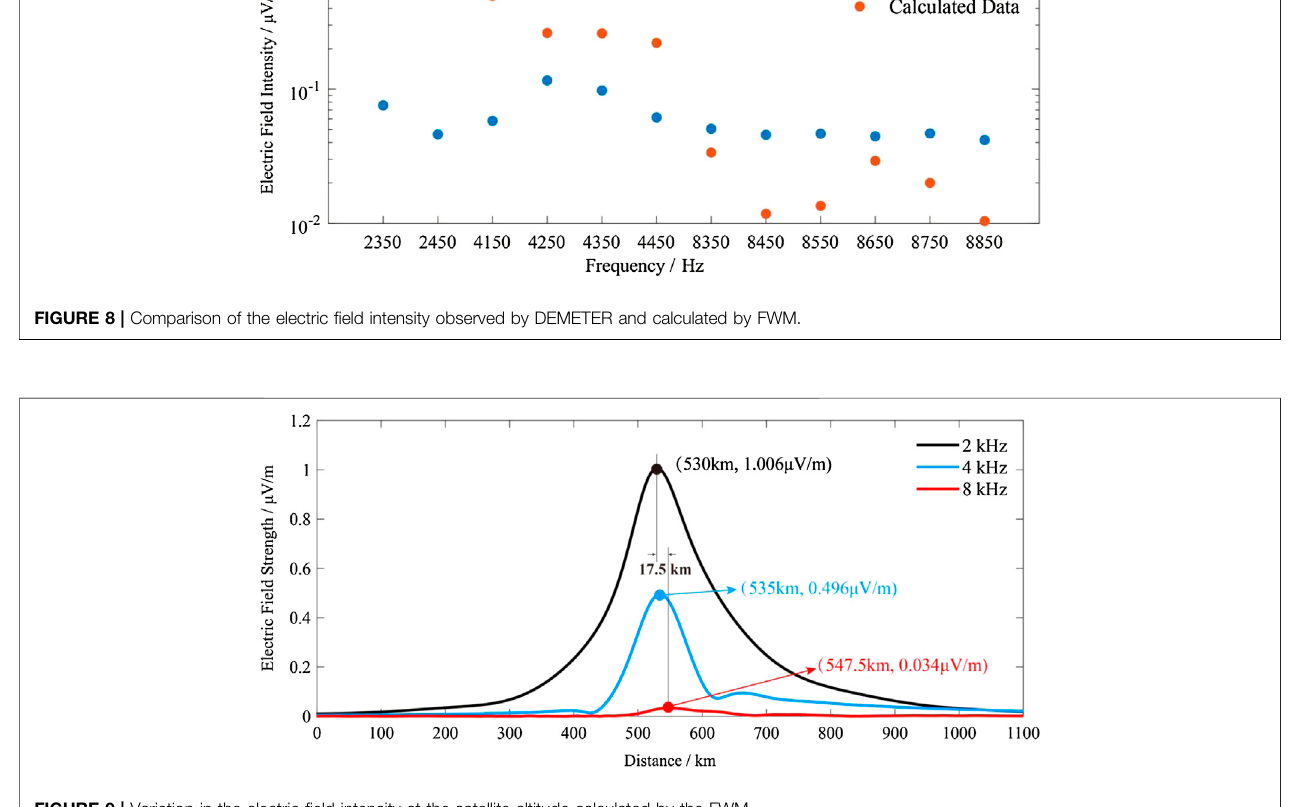
FIGURE 9 | Variation in the electric fi eld intensity at the satellite altitude calculated by the